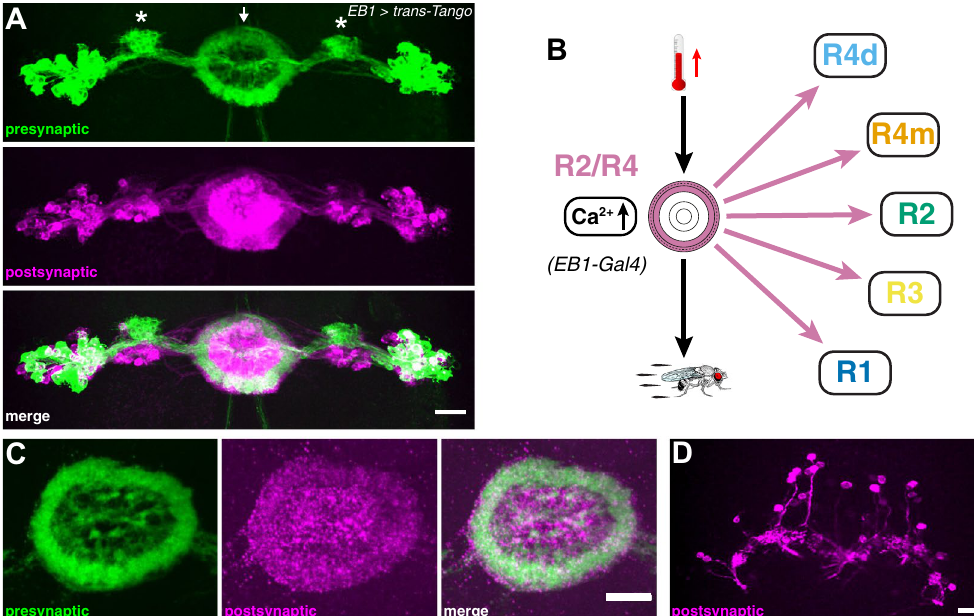
Figure 4. R2/R4 ring neurons connect to all EB rings. ( A ) trans -Tango based anterograde transsynaptic tracing of EB1 - targeted R2/R4 ring neurons indicates connections onto R1–R4 ring neurons. Detail of the central brain showing presynaptic signal (top, green), the postsynaptic targets (middle, magenta) and merged image (bottom) of EB cell bodies and ring neuropil (arrowhead), as well as the bulb (asterisks). ( B ) R2/R4 neurons connect to all R1–R4 EB rings; they integrate temperature increase and mediate thermoresponsive motor behavior. ( C , D ) Details of the trans- Tango signal of EB1-targeted R2/R4 neurons showing ( C ) detail of the EB ring neuropil region with presynaptic (left, green), postsynaptic (middle, magenta) and merged signal (right) revealing connections to R1–R4 layers as well as ( D ) to columnar neurons and the protocerebral bridge. Scale bars, 20